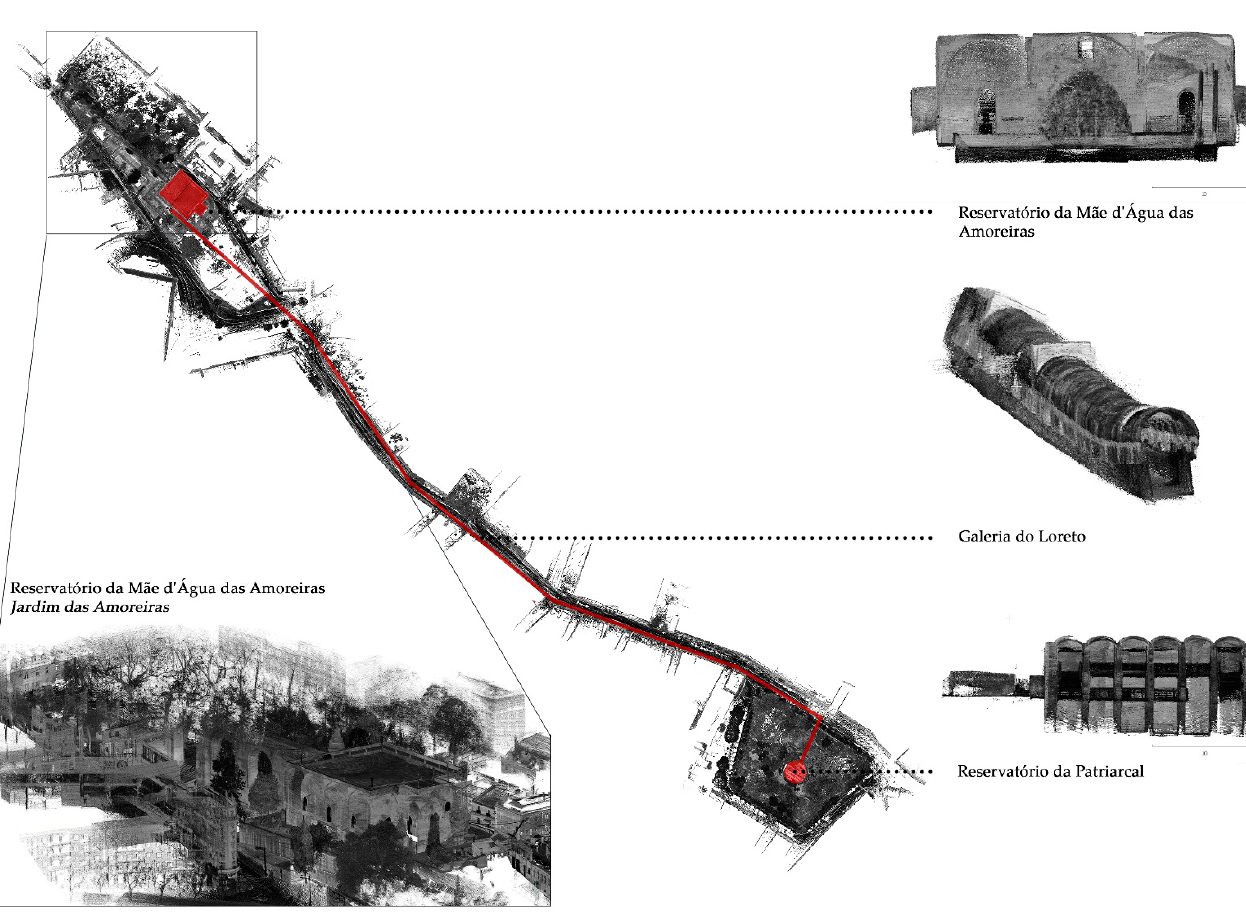
( b ) Figure 8. ( a ) Nikon KeyMission 360; ( b ) Image captured with spherical camera. 4. Results and Discussion After the preliminary stages of research and data acquisition, followed by structuring of descriptive and historical data and processing of survey data, the collected data were processed for their integrated management in a GIS environment. Figure 9 shows the elaboration scheme of the 2D/3D models that will be illustrated in the following paragraphs (Sections 4.1 and 4.2).